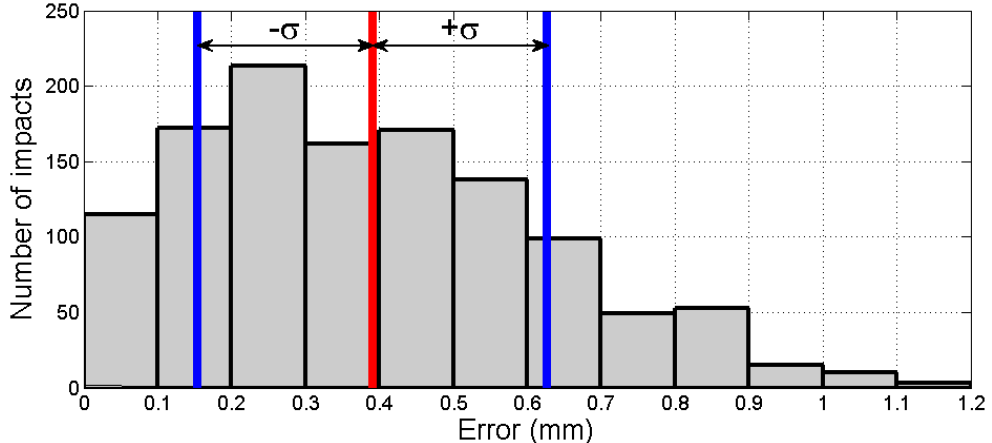
Figure 14. Results of the proposed methodology after 1,200